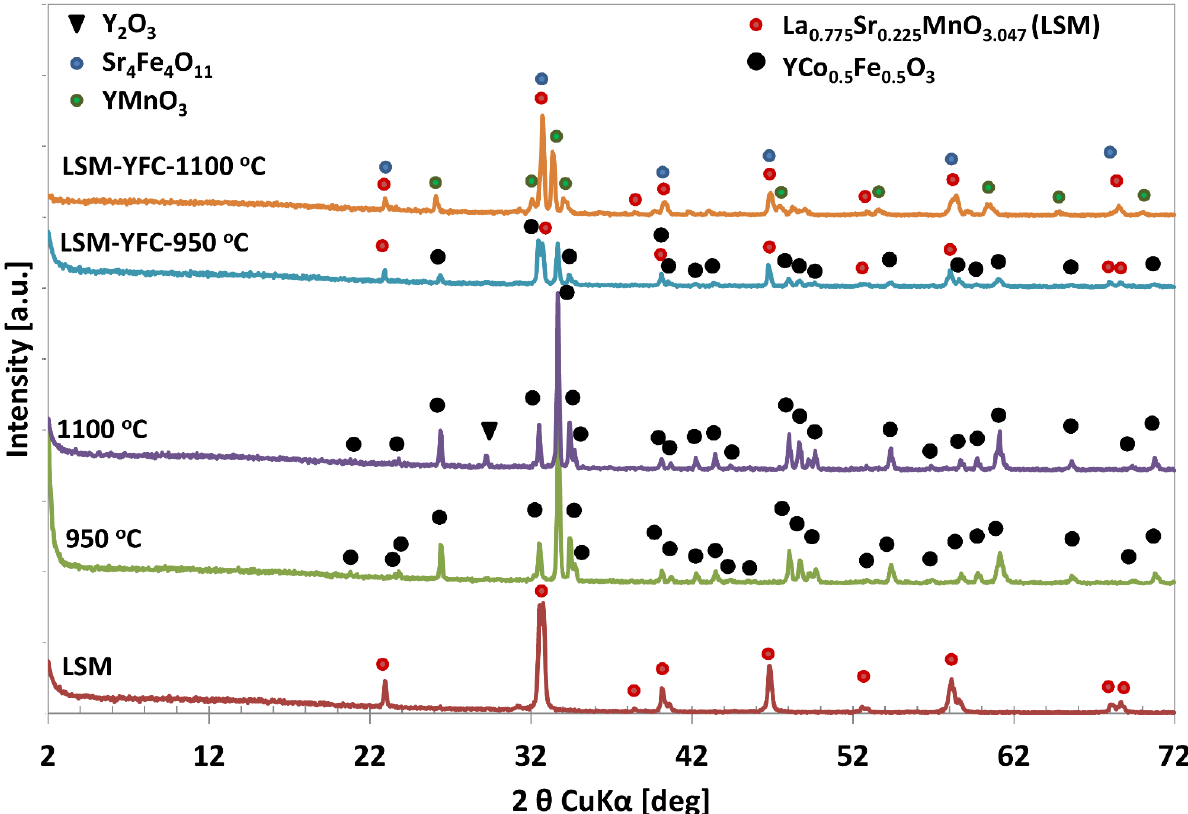
Figure 2. XRD patterns of YFC sintered at 950 °C (green) and 1100 °C (violet); LSM (brown); YFC mixed with LSM and sintered at 950 °C (blue) and 1100 °C (orange).